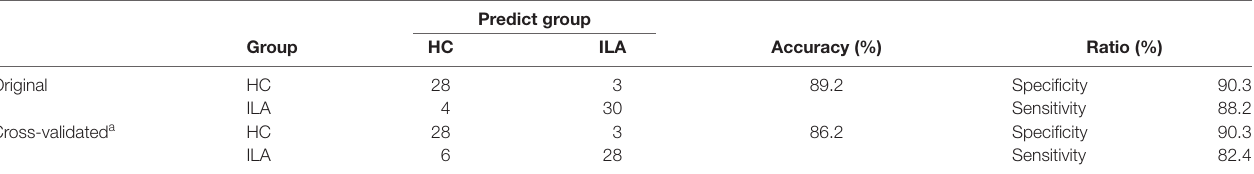
TABLE 2 | Summary of exploratory classification results of ILA and HC